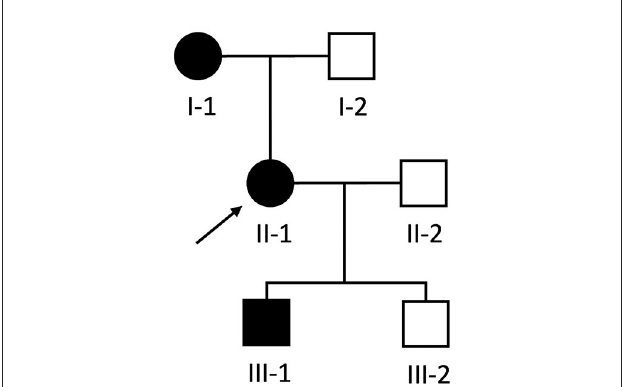
FIGURE1 Pedigree of Case 1 (II-1) and Case 2 (III-1). Proband is indicated by the black arrow. Black and white shapes indicate clinically affected and unaffected individuals, respectively. Squares and circles indicate males and females,